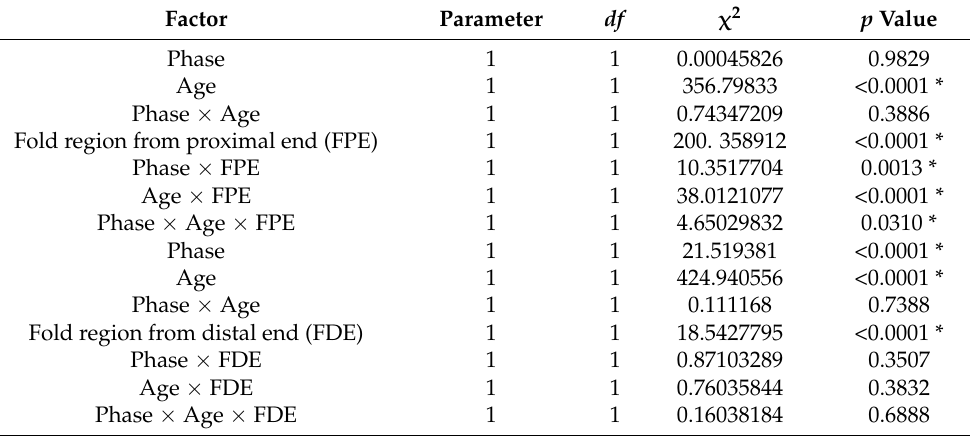
Table 4. The results of ordinary logistic regression analysis on the effects of phase variation and adult age on sperm storage in the desert locust Schistocerca gregaria , when sperm accumulation was counted from the proximal end or distal end of the folded seminal